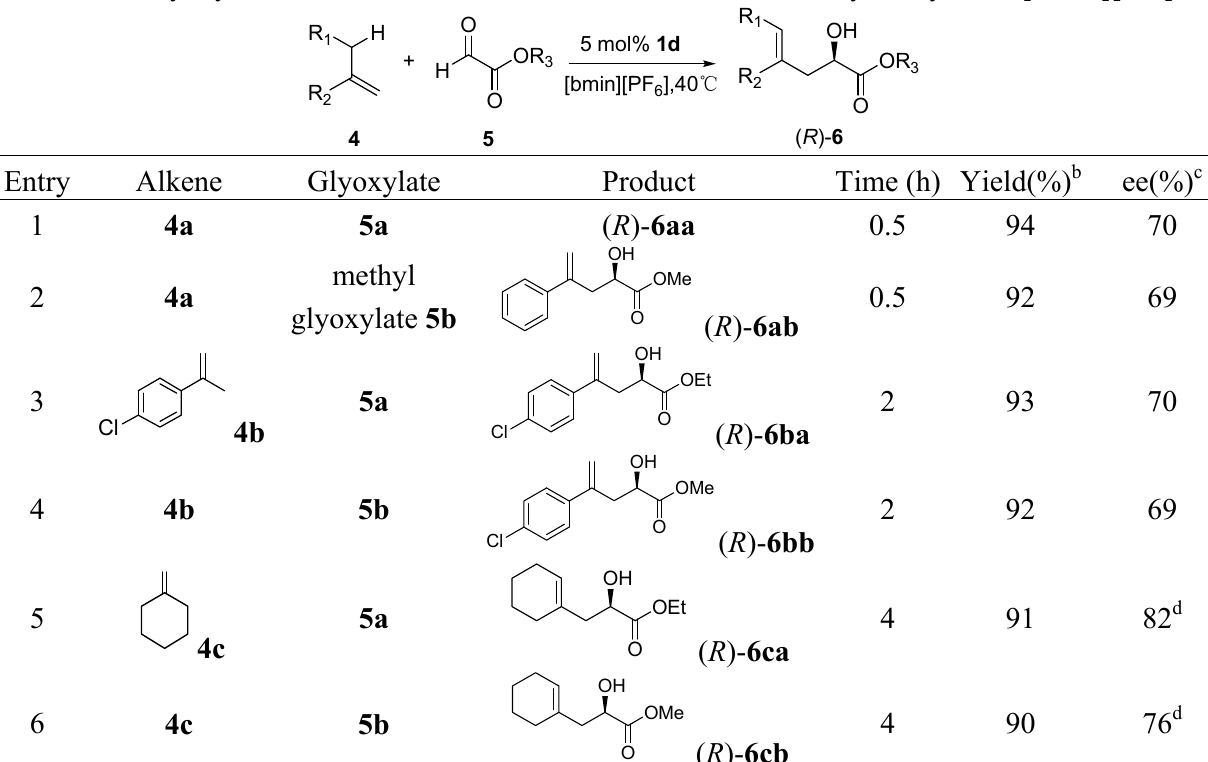
Table 4. Glyoxylate-ene reactions between different substrates catalyzed by 1b in [bmim][PF